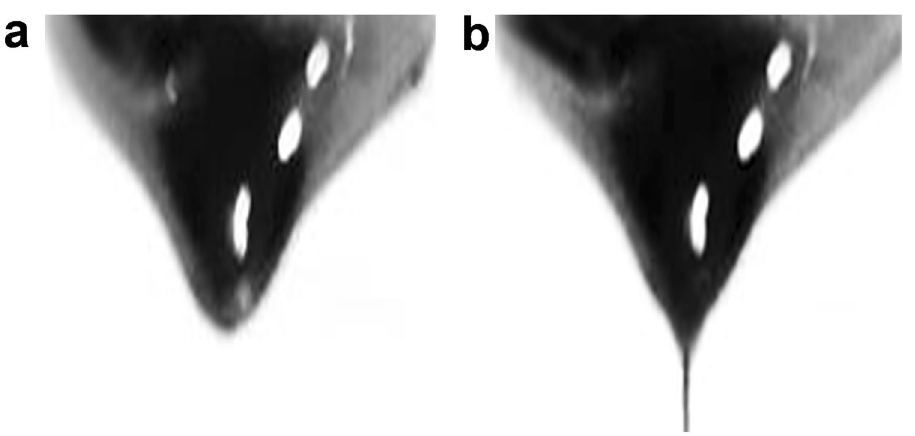
Figure 11. Magnetic droplets stretched by magnetic force to form